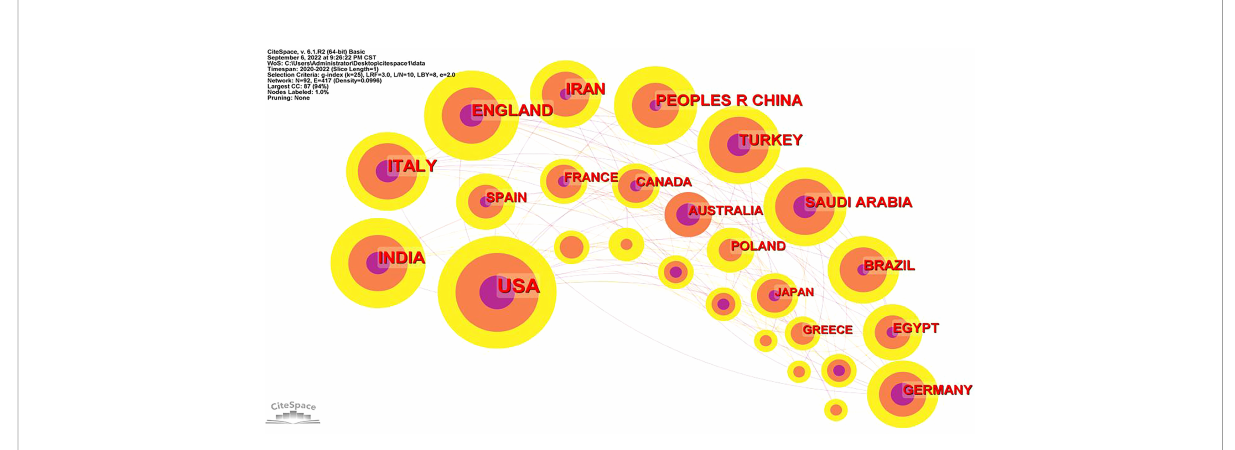
FIGURE 5 Network of cooperation among countries/regions.